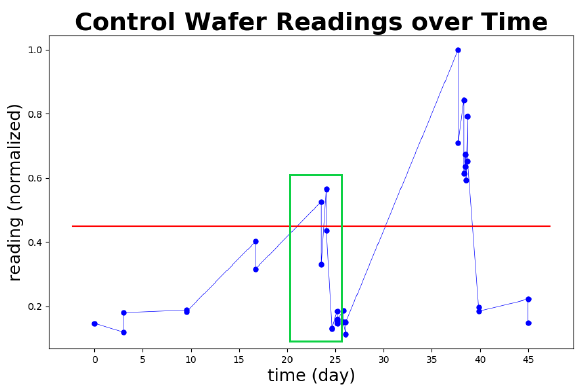
Figure 16. Advancement to anomaly detection by STALAD comparing to the control wafer reading monitoring for the whole anomaly event described by Table 6.